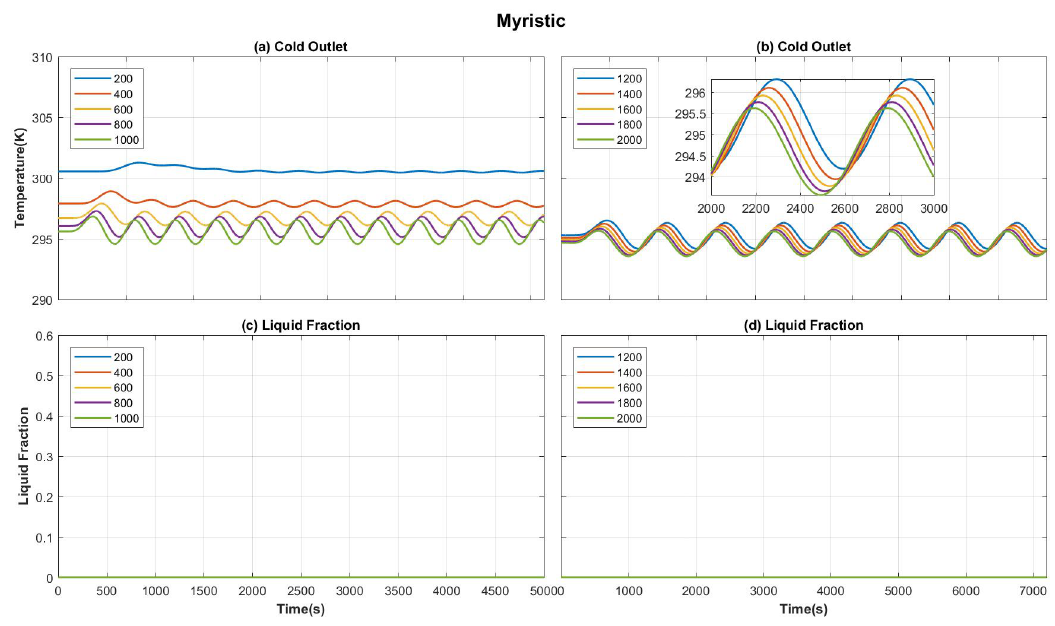
Figure 7. Cold outlet temperature and liquid fraction for myristic acid ( T s = 330.65 K, T l = 331.65 K) at Reynolds from 200 to 2000. Reynolds 200–1000 on the left ( a , c ) and 1200–2000 on the right ( b , d ). The PCM is not active as seen in ( c , d ), as the material in the PCM layer never reaches the much higher phase change temperature, thus ( a , b ) show results for sensible heat storage only.